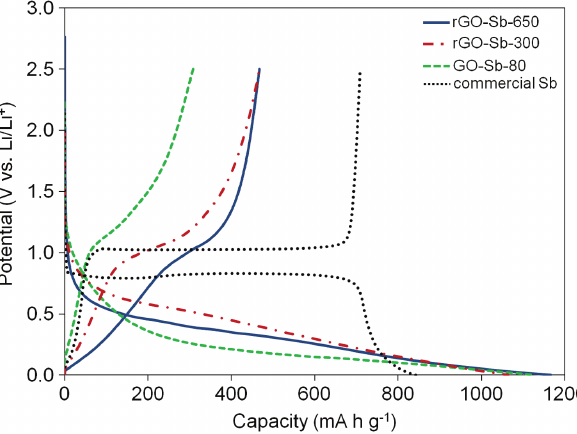
Figure 4: First-cycle charge and discharge profiles of different electrodes.